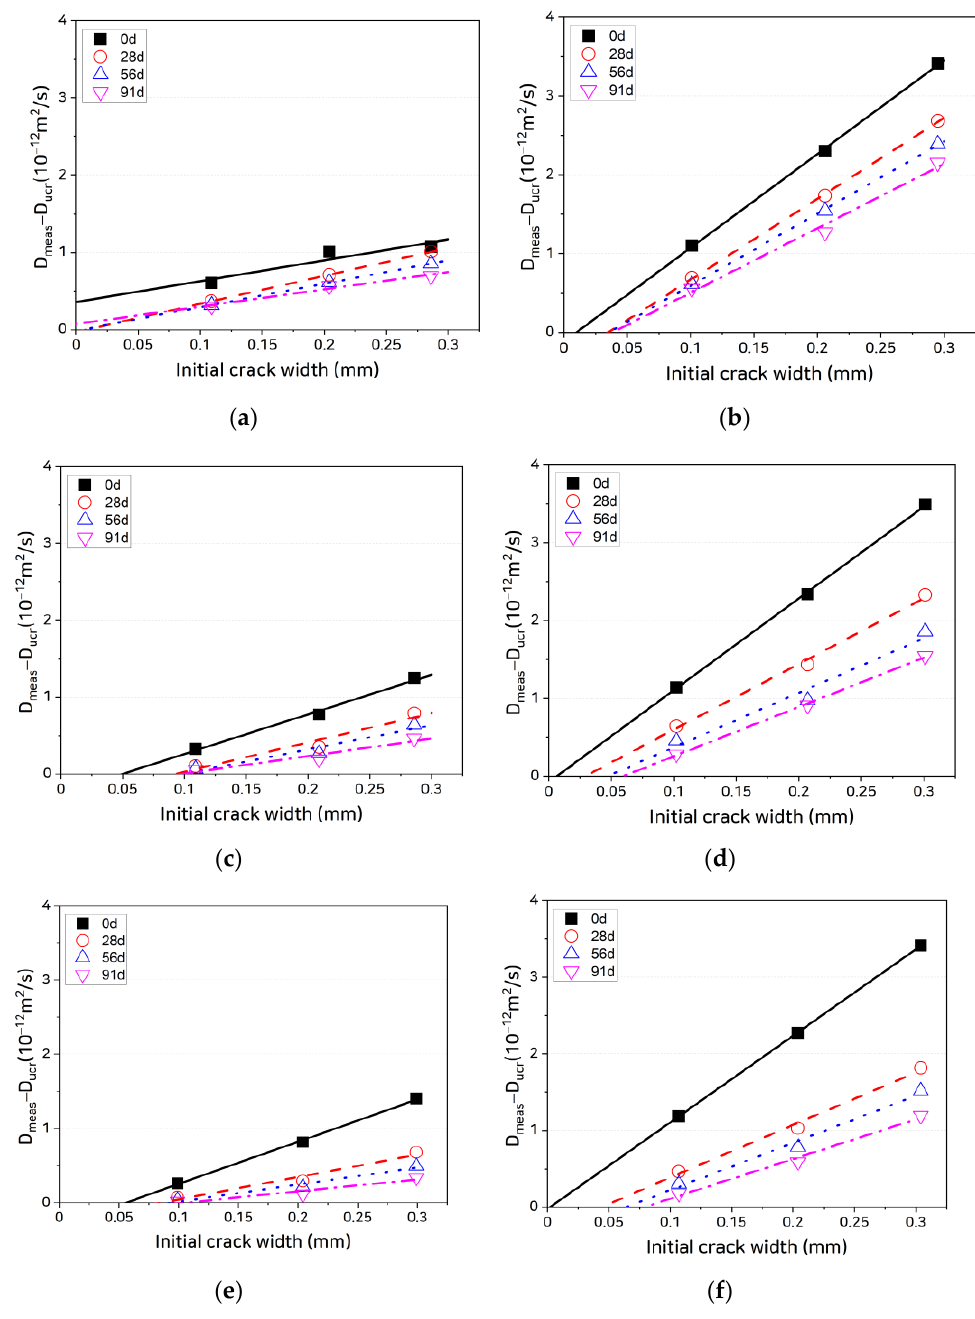
Figure 8. Diffusion coefficient through cracks as a function of crack width: ( a ) OPC, uncoated; ( b ) OPC, coated; ( c ) SHC15, uncoated; ( d ) SHC15, coated; ( e ) SHC30, uncoated; and ( f ) SHC30, coated.